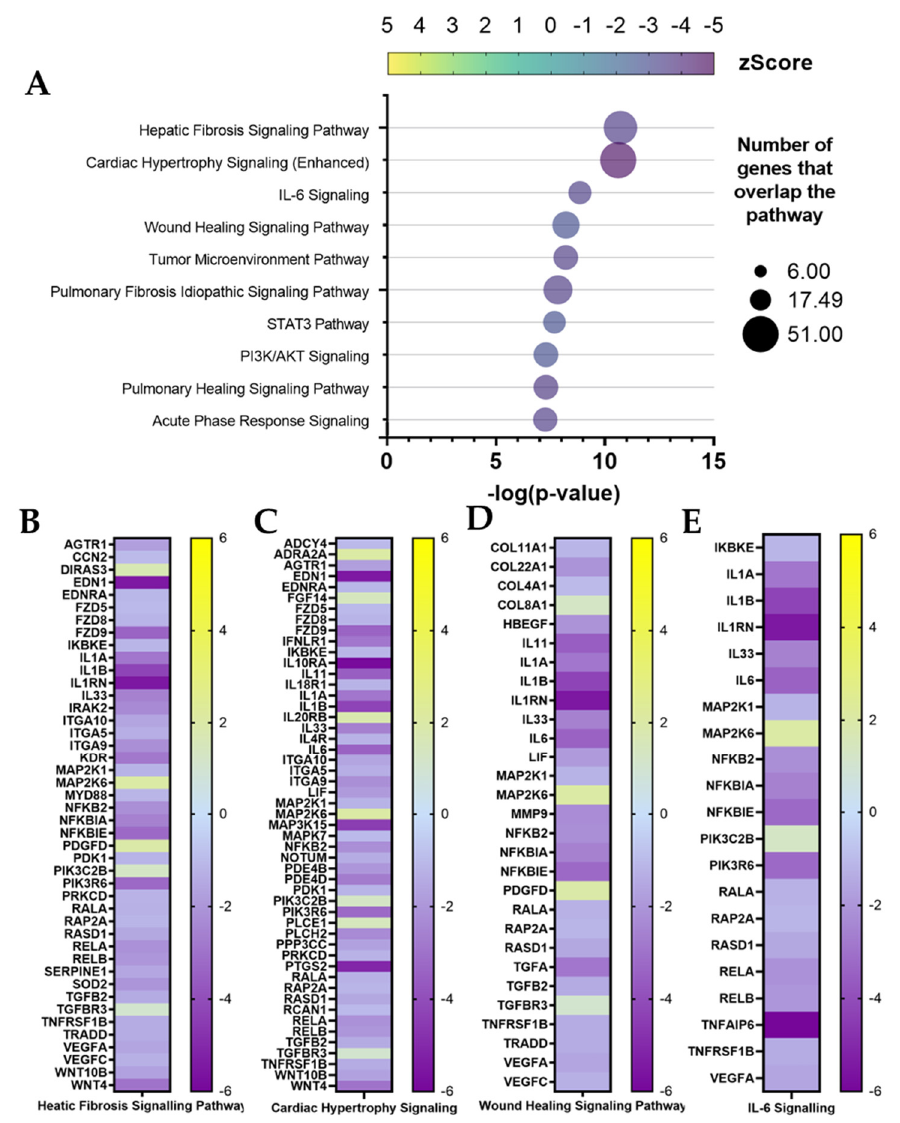
Figure 7. Canonical pathway analysis by IPA for w/ TNF α . ( A ) Ten first entries. ( B – E ) Genes involved in the first four pathways with expression log ratio values.